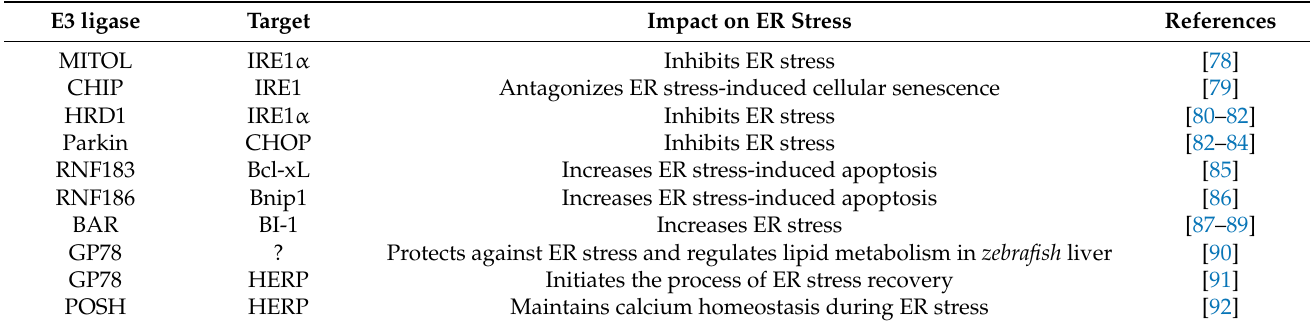
Table 1. E3 ubiquitin ligases and target proteins involved in the endoplasmic reticulum (ER) stress. E3